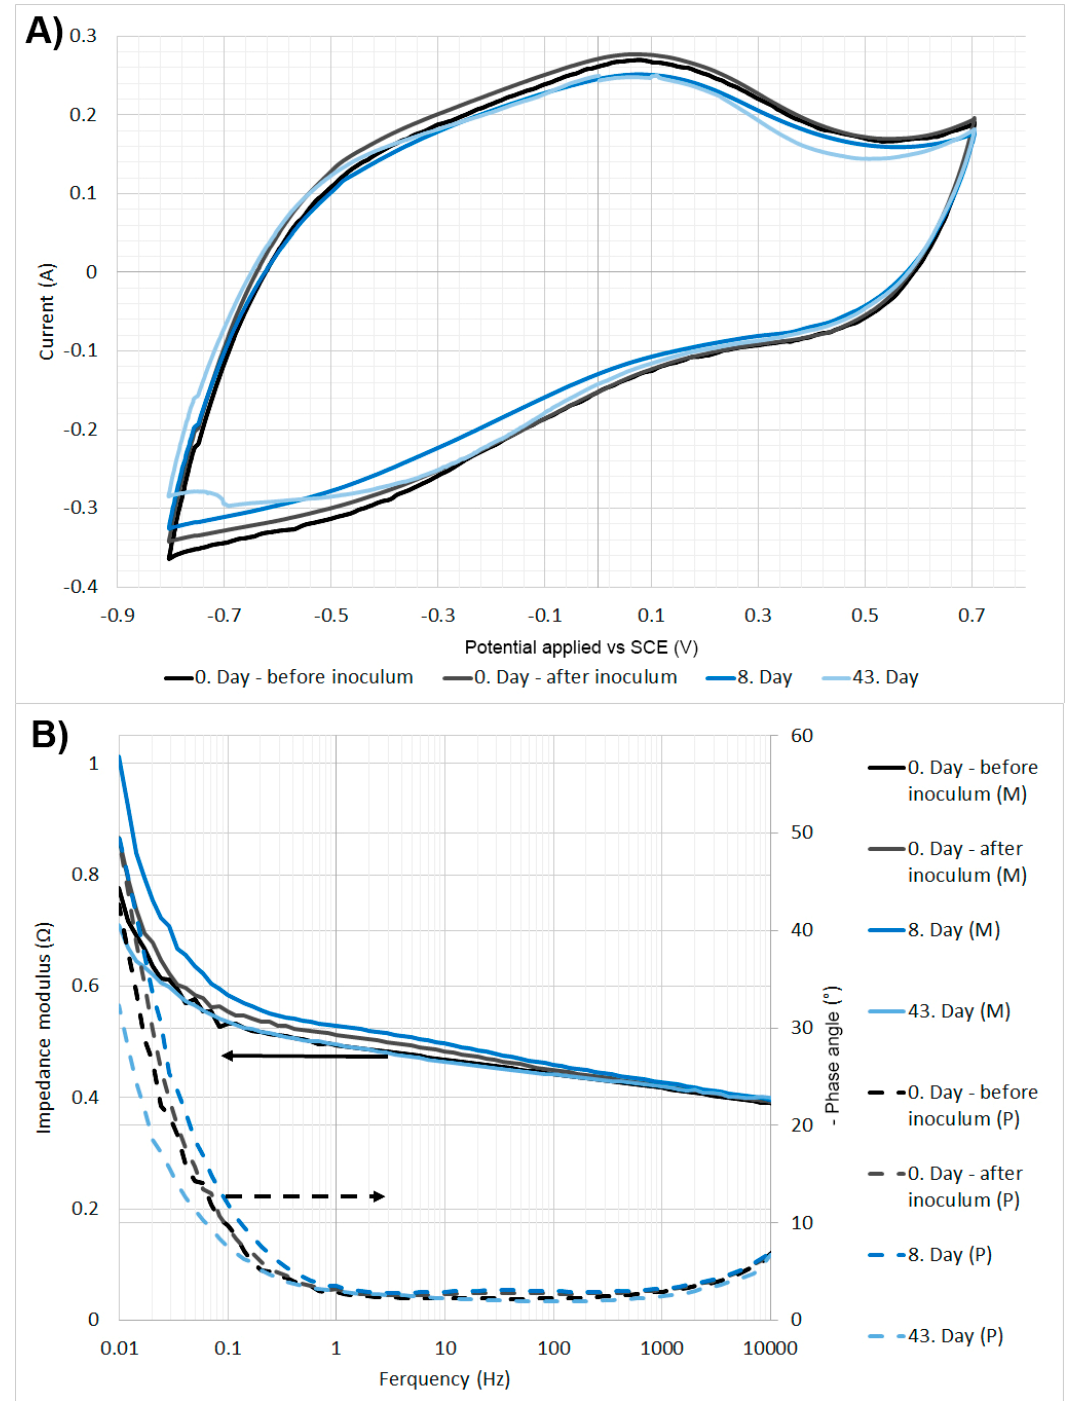
Figure A2. ( A ) The biocathode’s cyclic voltammetry from − 800 mV to +700 mV vs SCE at scan rate of 2 mV/s. ( B ) The biocathode’s electrochemical impedance spectroscopy—Bode plot, (M)—modulus, (P)—phase.